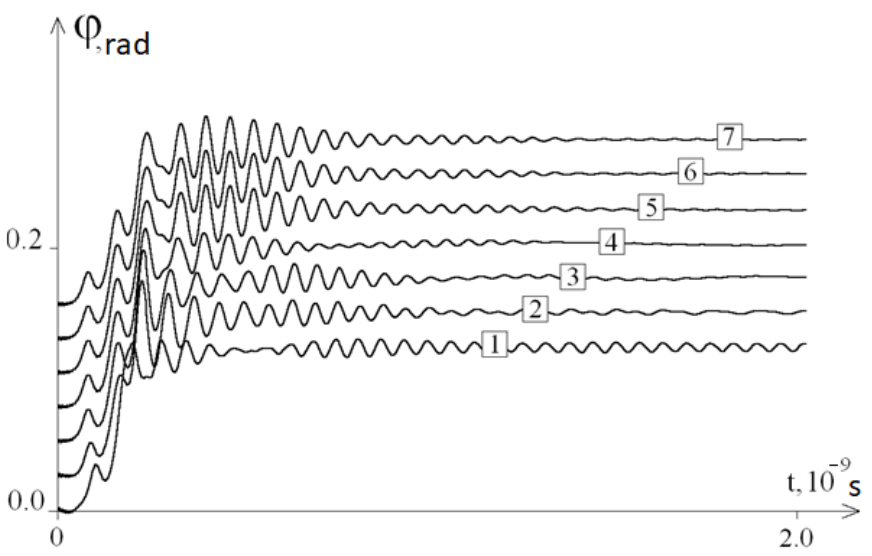
Figure 4. The average angular deviations (with a vertical shift) of the first DNA chain with 40A substitution for different orders of p frequency of external periodic exposures: 1— ω = 10 11 s –1 , 2— ω